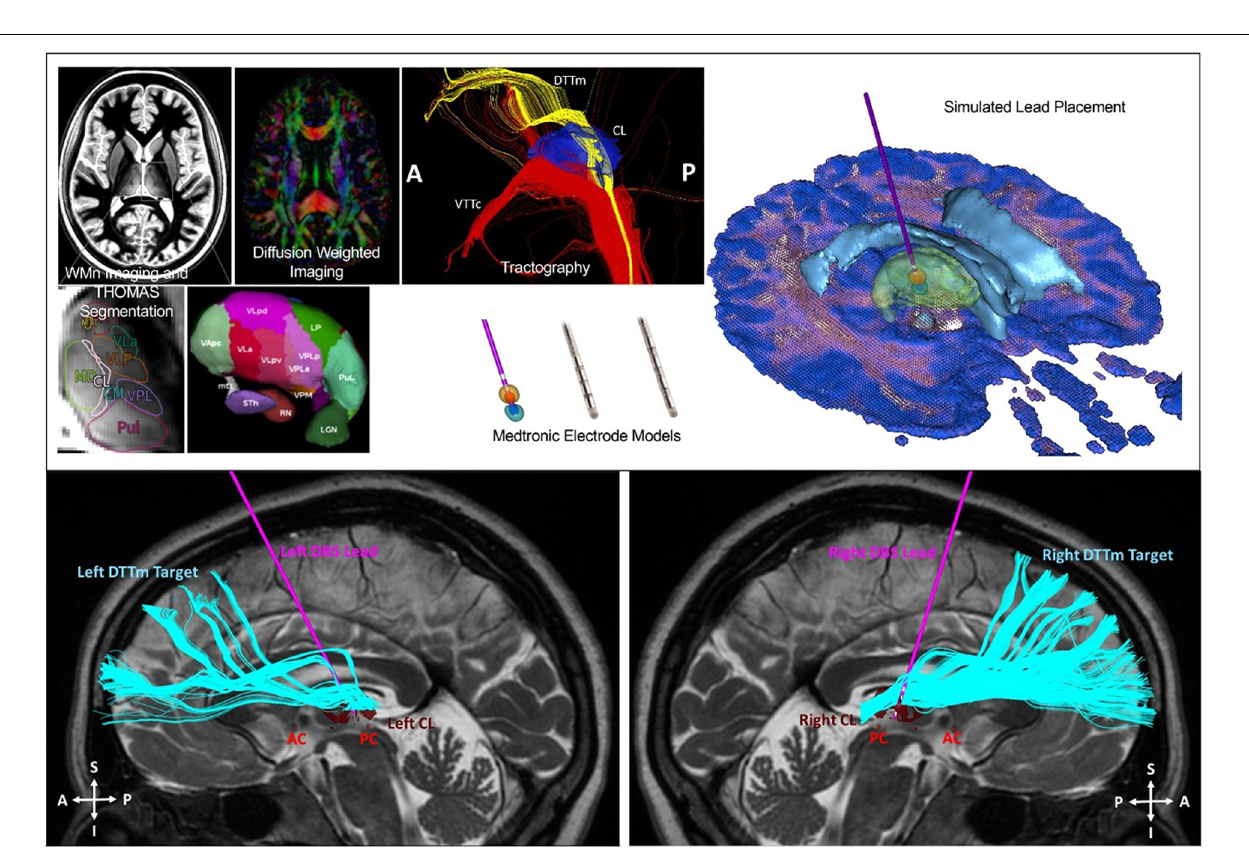
Frontiers in Human Neuroscience |